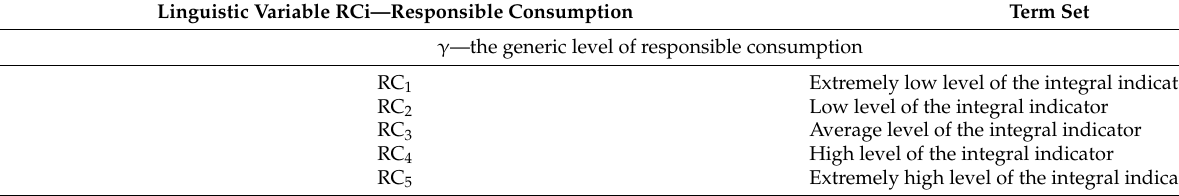
Table 35. Term ‐ sets of linguistic variables.